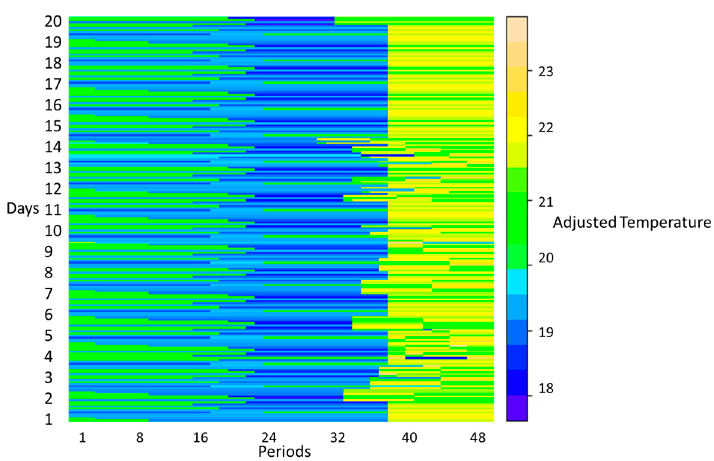
Figure 8. Adjusted temperature by users in each period for 20 days.